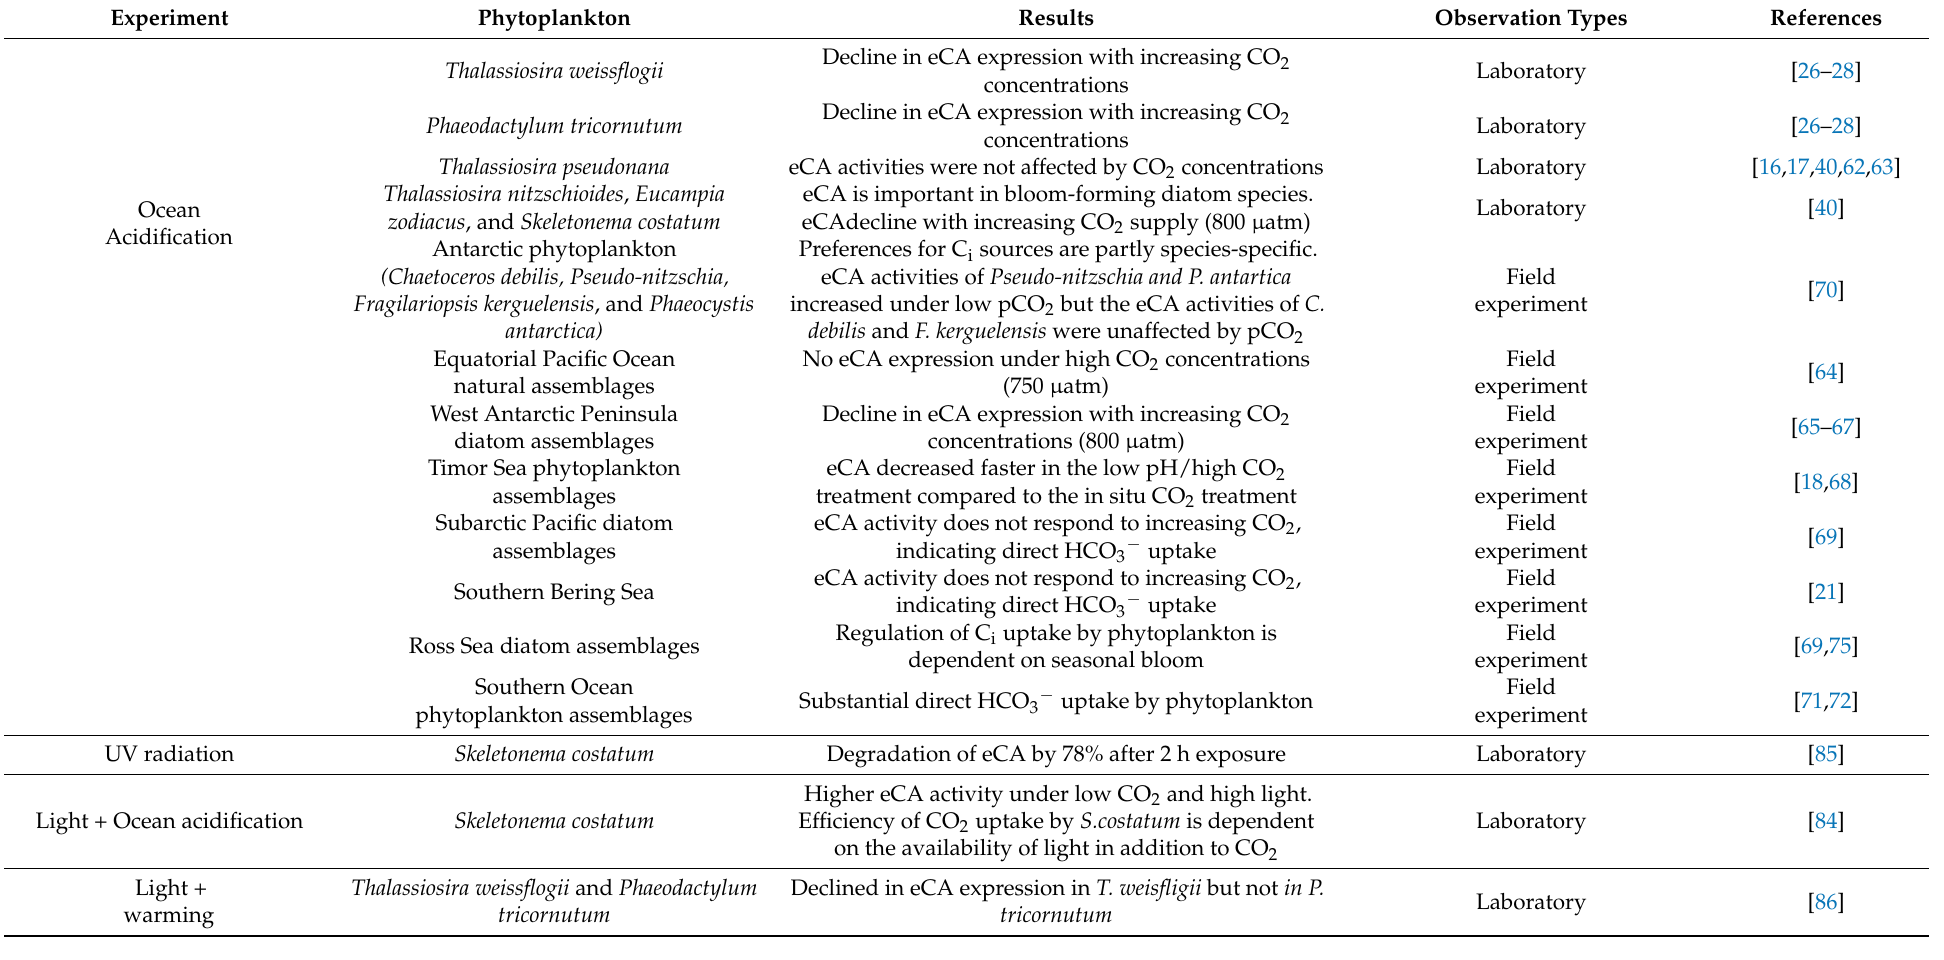
Table 1. Studies on the effect of ocean acidification, UV radiation, light, warming, and combination effect on carbon acquisition strategies of phytoplankton through laboratory